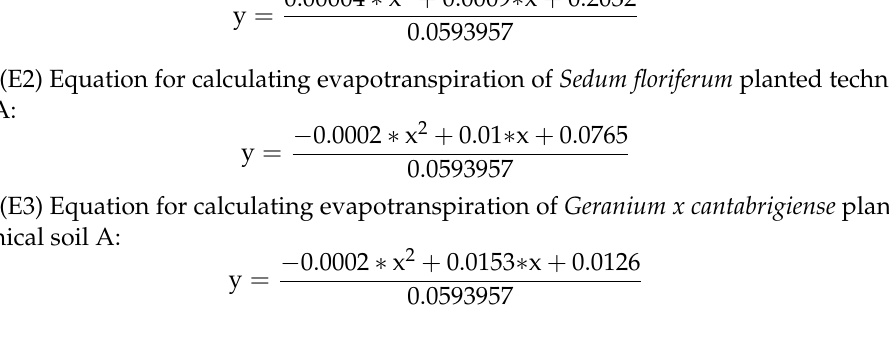
Figure 4. Regression lines were inserted through the differences in weight of any technical soil C–F in climate scenario I, II, and III, to create equations for calculating evapotranspiration.